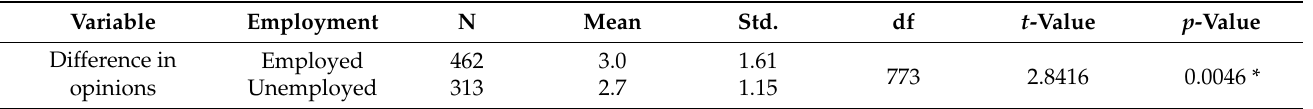
Table 8. Difference in external factors influence for purchasing luxury brands (by